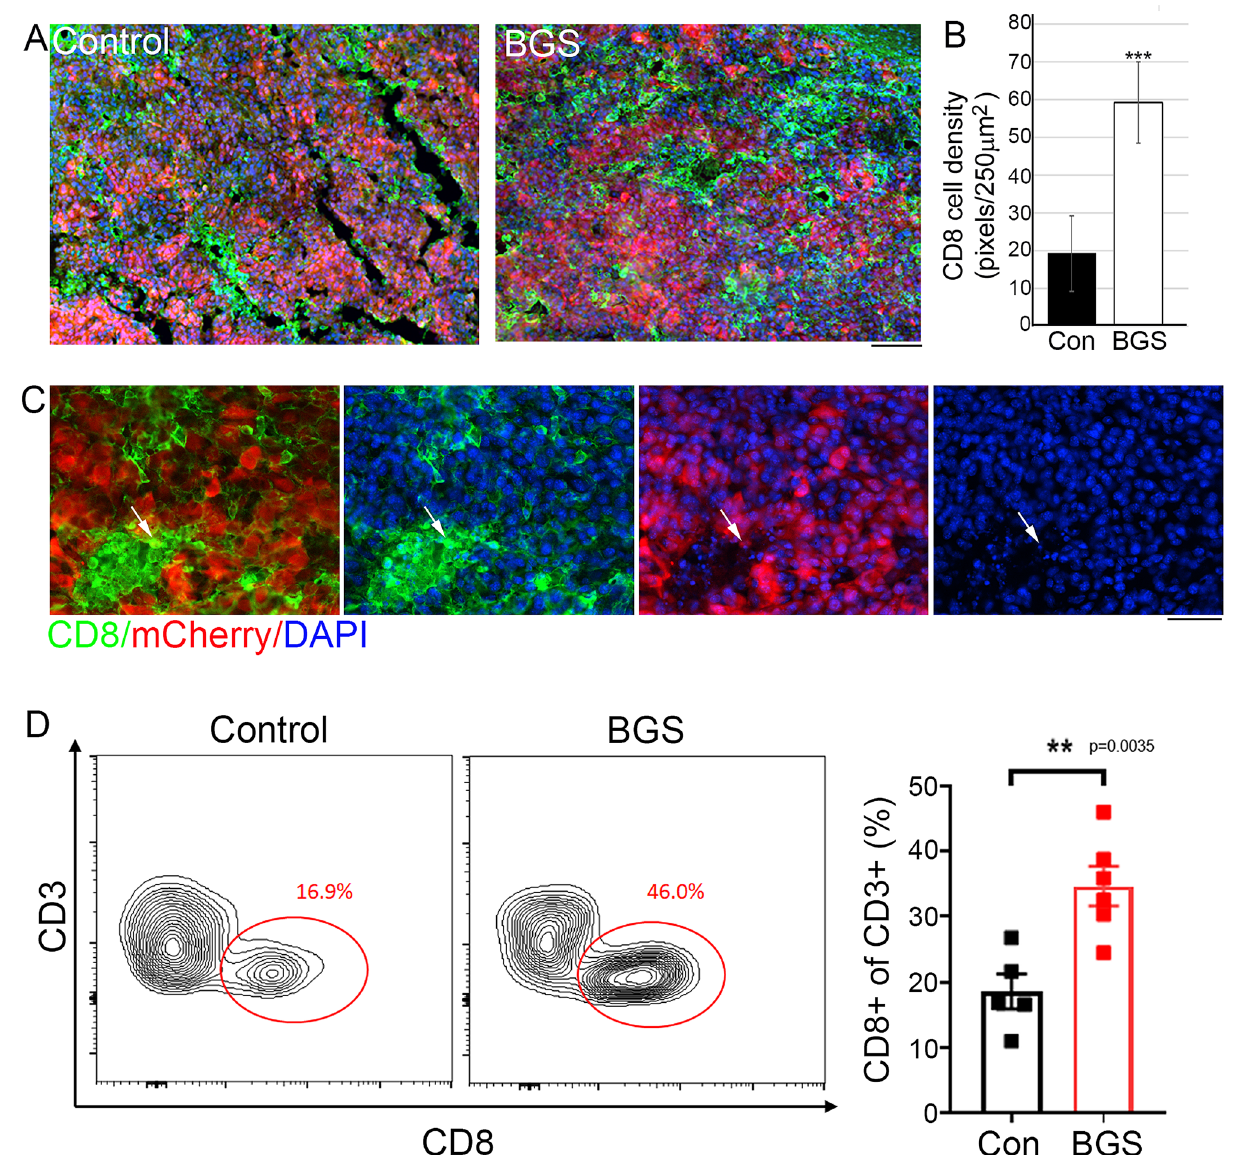
Figure 6. BGS treatment increased CD8 + cells invasion into the tumor. ( A ) Representative images of the control and BGS treatments for CD8 + cells (green) in the tumor (mCherry). Scale bar 200 µm. ( B ) CD8 + cell density is significantly increased in the BGS-treated group compared to the control group. Results are presented as mean ± SD (n = 7 animals/group; ***p < 0.001). ( C ) Arrows indicate an example of a CD8 + cell phagocyte mCherry positive RET melanoma cell, scale bar 50 µm. ( D ) Flow cytometry analysis of CD3 + CD8 + cell frequency in the tumours. Results are presented as mean ± SD (n = 5 brain tumors/each group; **p < 0.0035) from two independent melanoma cell death, we further examined whether tumor cell death was accompanied by an invasion of CD8 + cytotoxic cells into the tumor area. As demonstrated by both immunohistochemistry and flow cytometry, BGS treatment increased the infiltration of CD8 + cells into the tumor (Fig. 6A–C). Flow cytometry analysis revealed 37.4 ± 3.01% of CD8 + cells infiltration in BGS treatment, compared to only 18.6 ± 2.65% in the control group (Fig. 6D). The immune response consists of immune cell infiltration into tumor tissue and inhibitory signaling of tumor progression, depending on the tumor microenvironment 50–52 . Therefore, we next assessed the expres- sion of a phosphorylated signal transducer and activator of transcription 1 (p-STAT1), one of the IFN-gamma signaling pathway molecules. Our results demonstrated that the density of p-STAT1 within tumor cells was significantly elevated in the BGS treatment group, when compared with the control group (control 31.13 ± 3.9; BGS 55.12 ± 8.4) (Fig. 7A–C). An increase in p-STAT1 in BGS-treated animals was also confirmed by Western blot analysis (Fig. 7E), with a 27% increase compared to control. Furthermore, RET melanoma cells surrounded by CD8 + cells expressed a high level of p-STAT1, which was significantly increased within melanoma cells in the